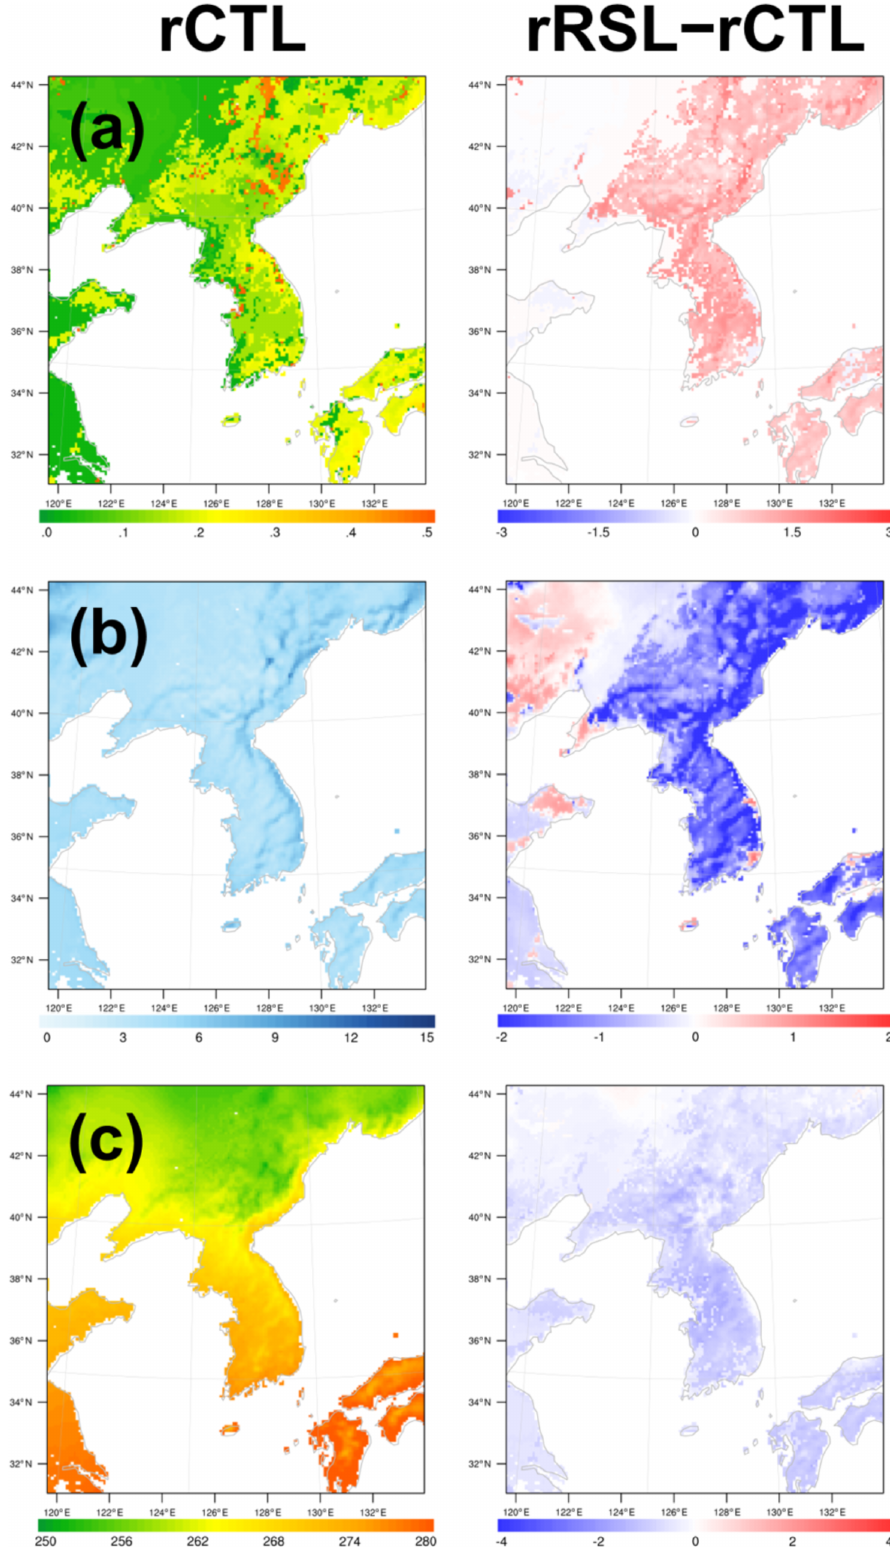
Figure 8. (a) Roughness length (m), (b) 10m wind speed (ms − 1 ), and (c) daytime 2m temperature (K) of the (left) rCTL experiment and (right) the difference (rRSL–rCTL). The results are averaged over a period of 1 month and masked out over the